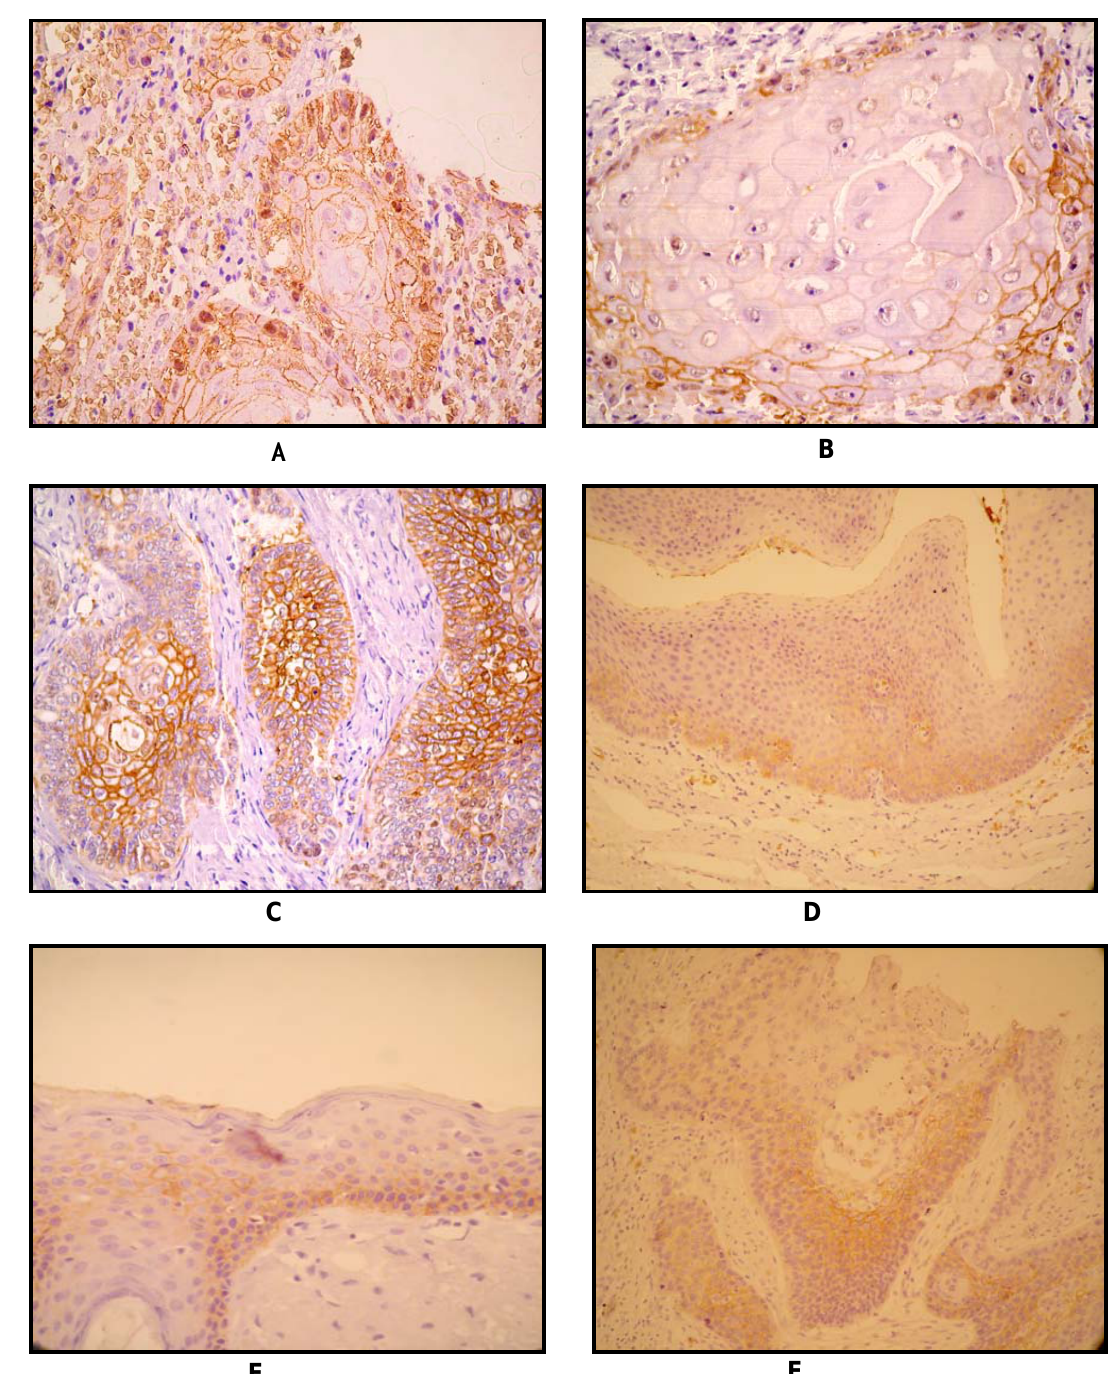
Figure 2. A) Keratinizing squamous carcinoma. GLUT1, prostromal staining pattern. Note positivity at periphery of tumour nest, in non-keratinizing basaloid cells, and loss of GLUT1 expression accompanying keratinization at the centre of tumour nest, 200×; B) 400×; C) Non - keratinizing poorly differentiated carcinoma, 100×. In the absence of squamous differentiation/keratinization: GLUT1 displays an antistromal pattern, suggestive of hipoxia-driven GLUT1 induction. D) and E) Basal staning pattern with the superficial layers showing little or no GLUT1 staining in the normal epithelium; F) GLUT1 immunostain (arrow). Squamous intraepithelial neoplasia, non- staining of basal